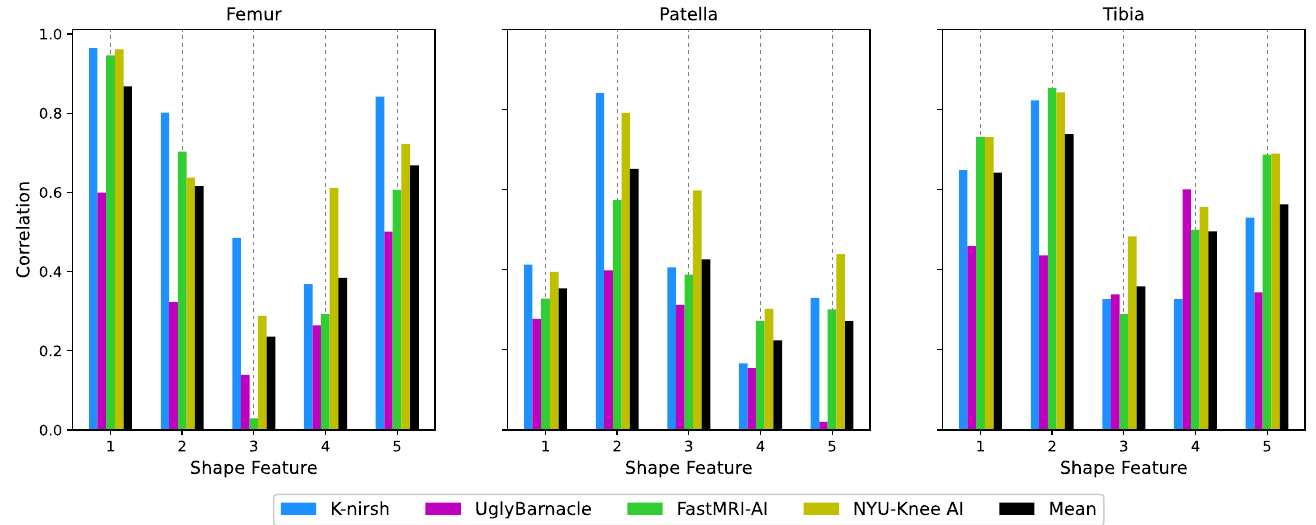
Figure 12. Correlations along femoral, tibial, and patellar bone shape features between submissions and ground truth. For many of the bone shape features, correlations were moderate to strong, indicating another means in which submitted segmentations from 8× undersampled images at times were suitable for downstream biomarker analysis. K-nirsh and NYU-Knee AI appeared to have strong correlations most consistently between predicted and ground truth bone shapes among the top 4 submissions.